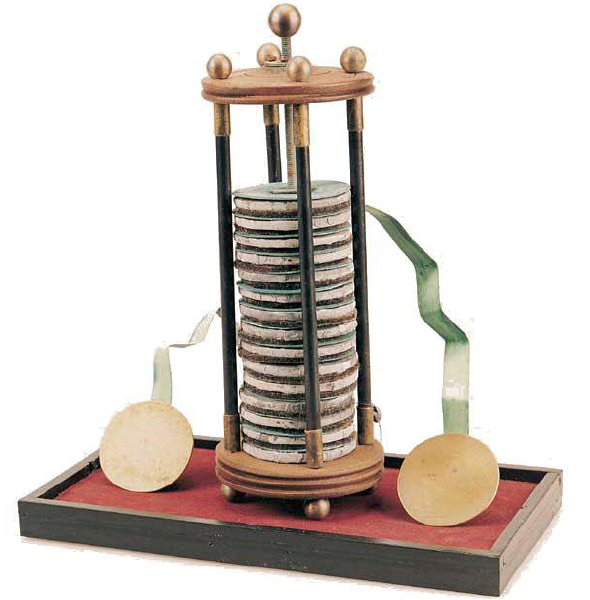
Figure 12. Alessandro Volta’s pile (modern reconstruction) [15].